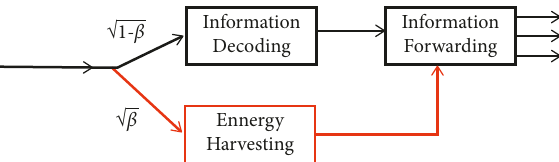
Figure 2: The power splitting structure of group